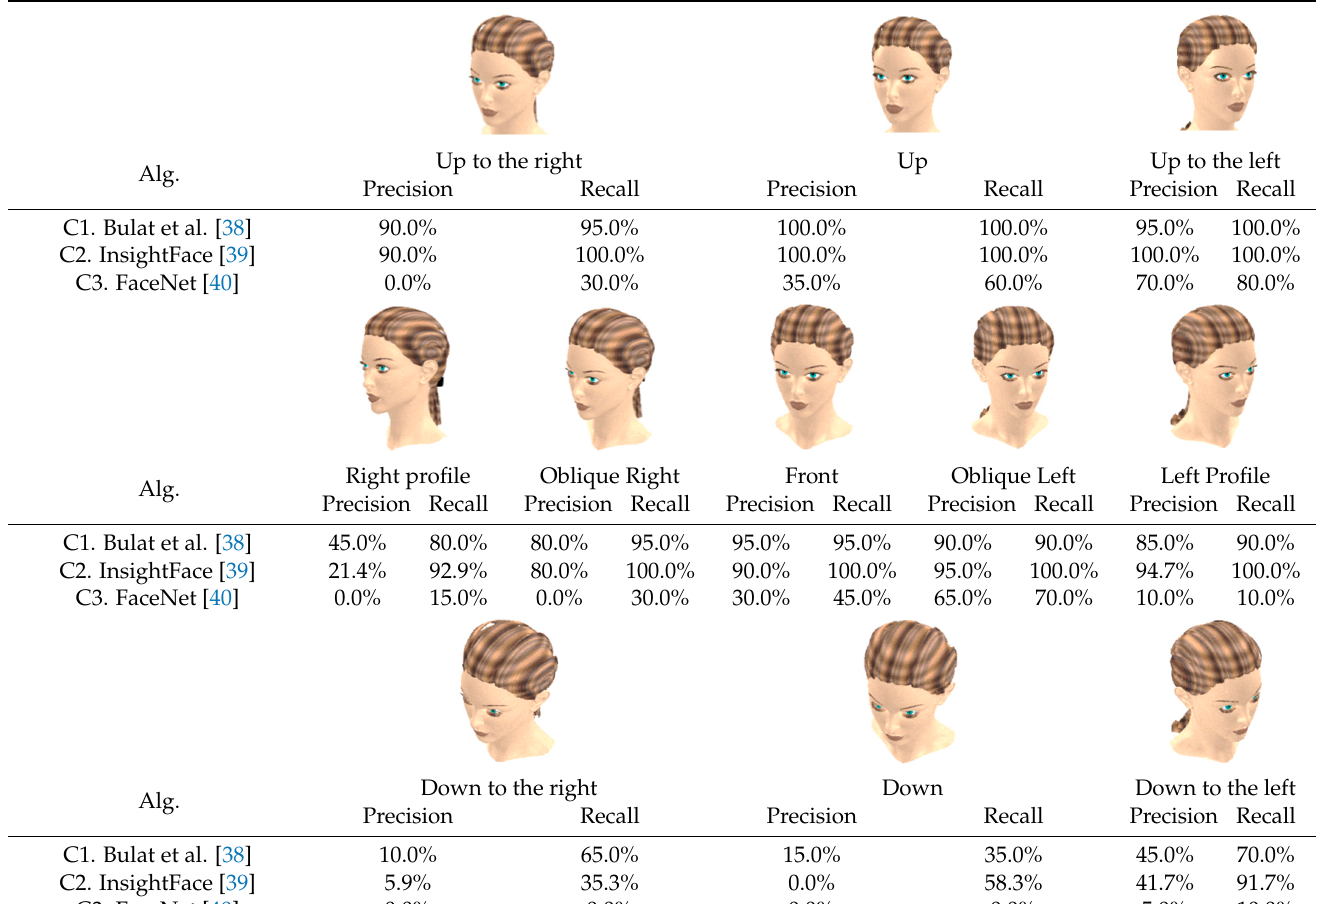
Table 1. Precision and recall for upward, lateral head orientations, and downward head orientations in all lighting settings.